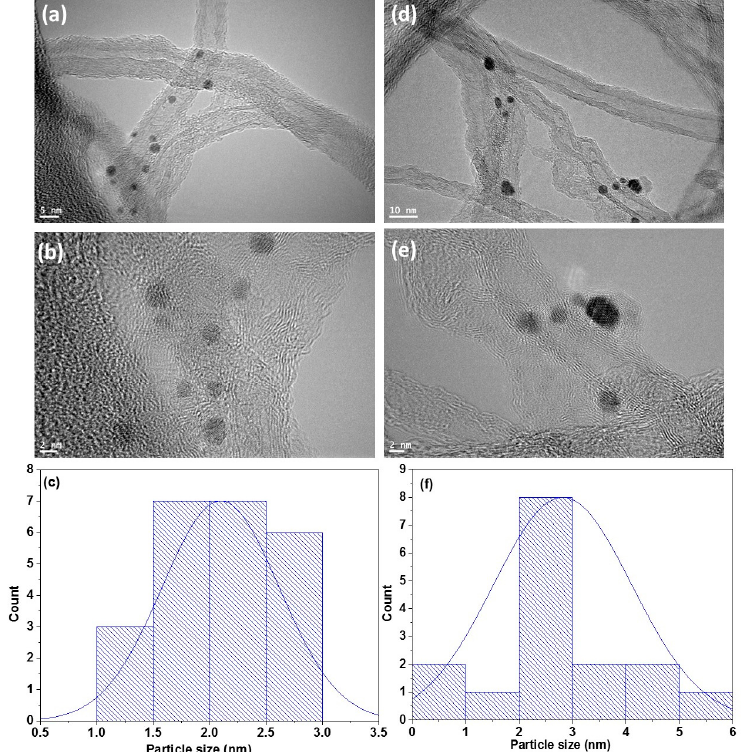
Figure 5. ( a , b ) High resolution transmission electron microscope (HRTEM) images and ( c ) particle size distribution histogram of the Au-Pd / O-CNTs and ( d , e ) High resolution transmission electron microscope (HRTEM) images and ( f ) particle size distribution histogram of the Au-Pd/P-CNTs.